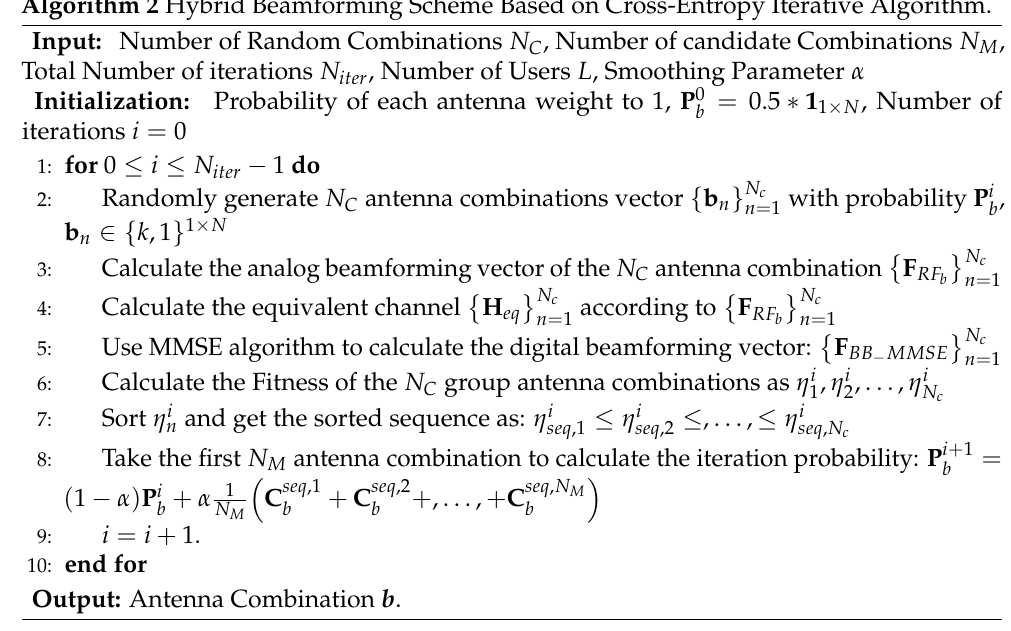
Random Selection Algorithm CE Optimal Algorithm